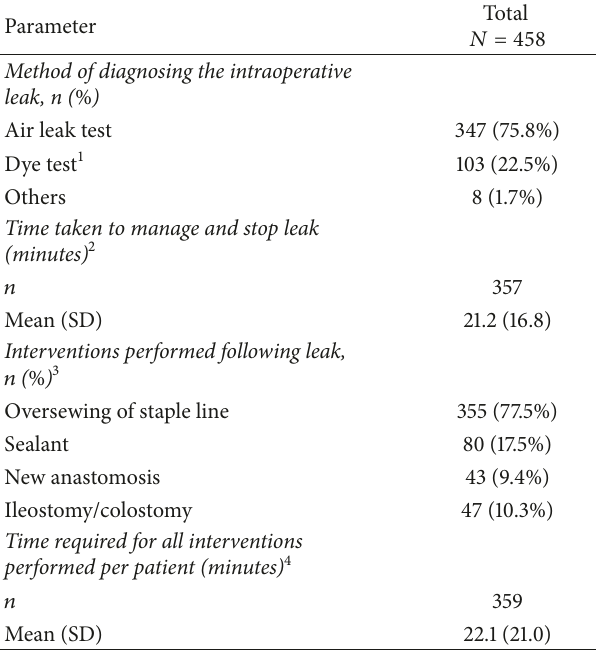
Table 2: Management of intraoperative anastomotic leaks.